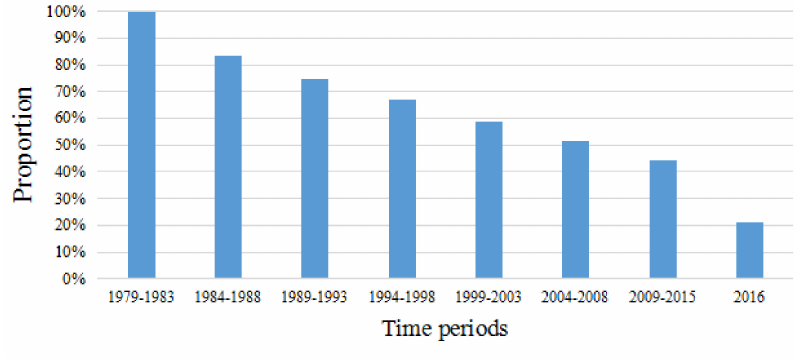
Figure 5. The proportion of multiyear ice area in different time